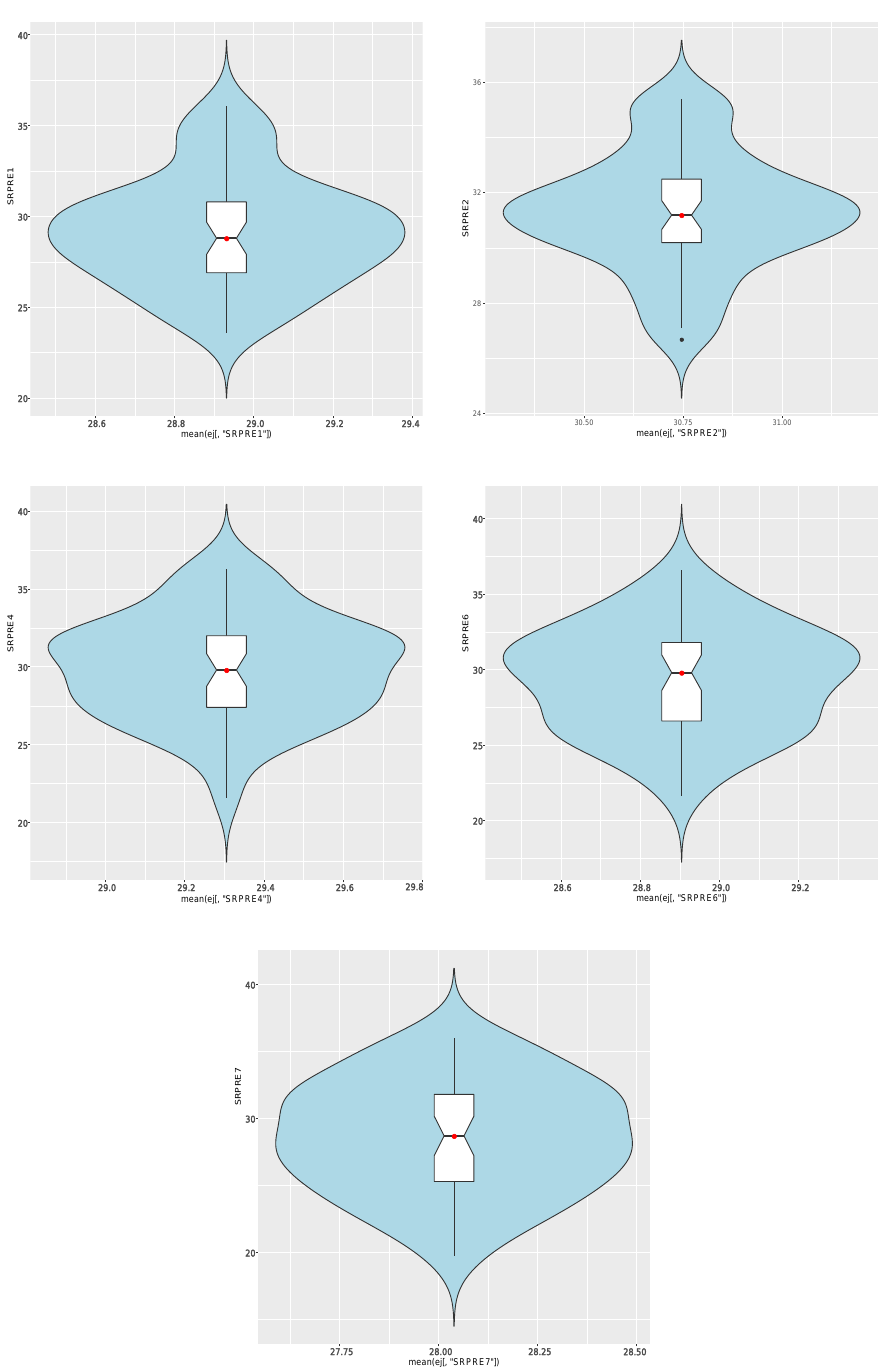
Figure 7. Violin plot for indices I j , j ∈ { 1,2,4,6,7 }